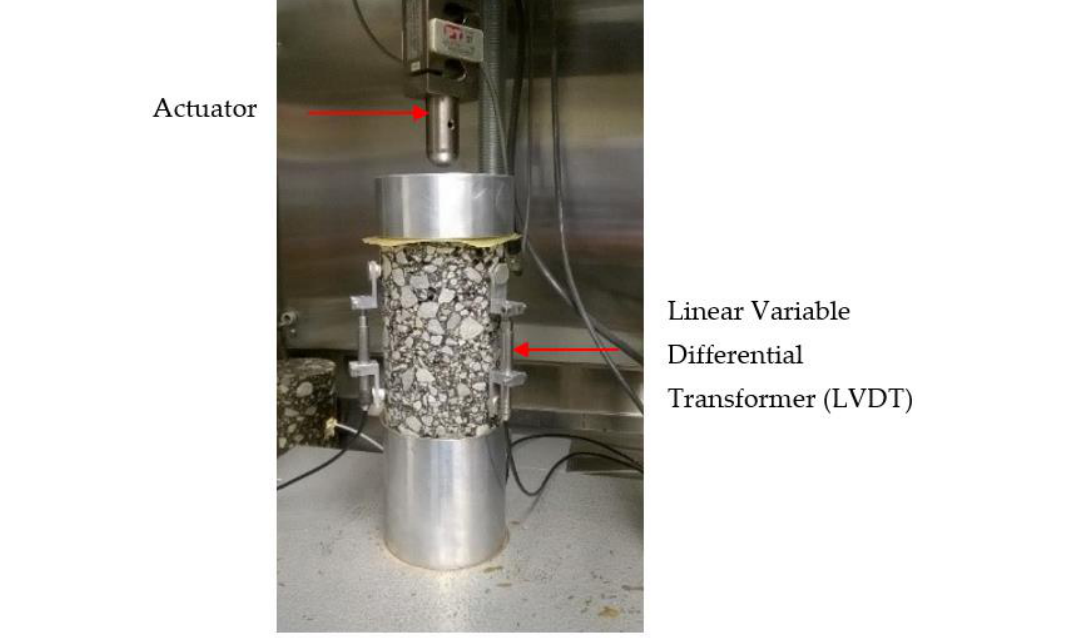
Figure 1. Dynamic modulus test setup.